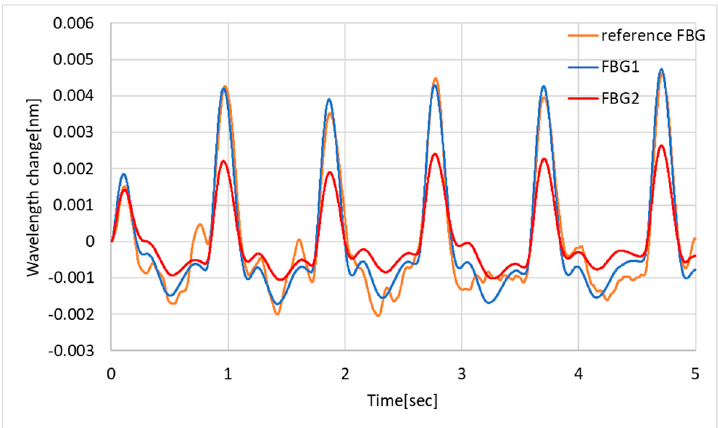
Figure 10. A Butterworth-type bandpass filter (order 2, low-cutoff frequency 0.5 Hz, high-cutoff frequency 5 Hz) is applied onto the data of Figure 9. The offset value of the reference FBG is subtracted before filtering.